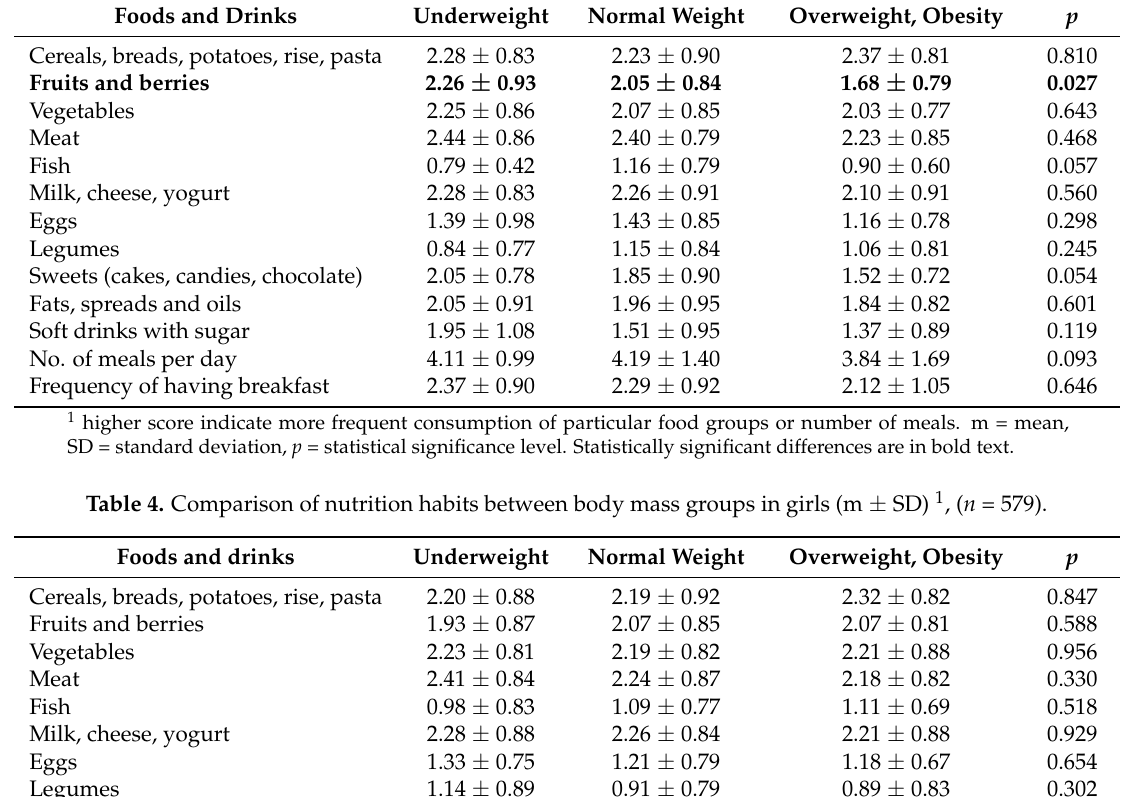
Table 3. Comparison of nutrition habits between body mass groups in boys (m ± SD) 1 , ( n = 579). Foods and Drinks